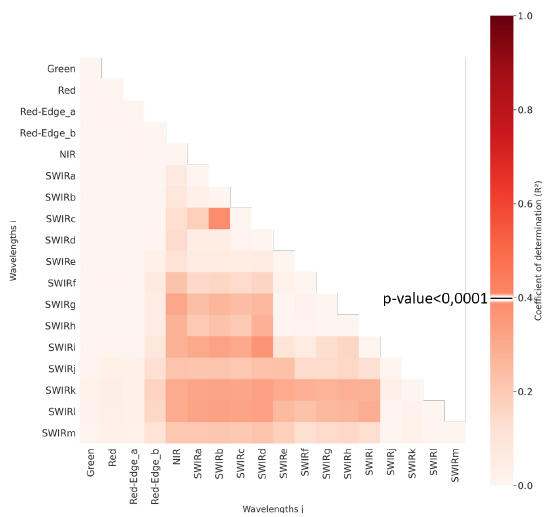
Figure 19. Correlation matrix between NDSI using the reflectance value average by domains and SWP for all plots.